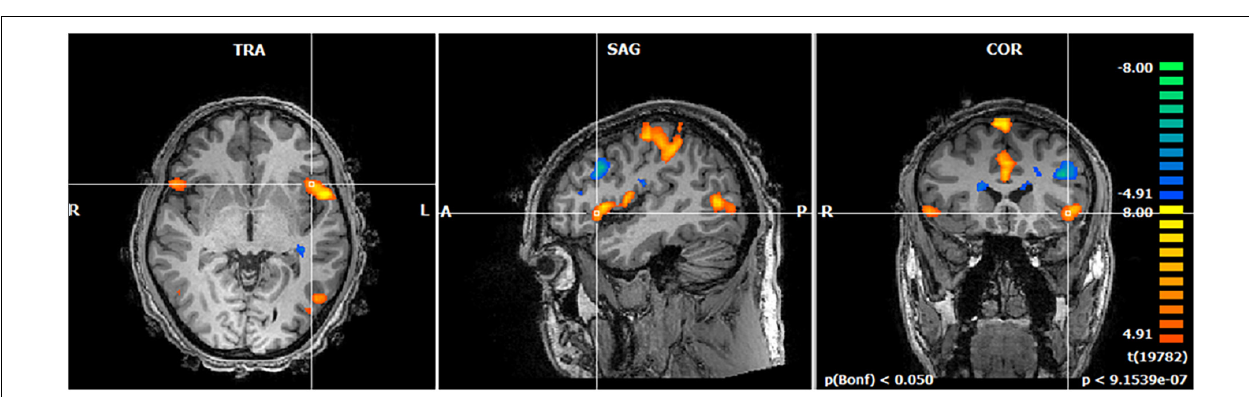
FIGURE 3 | Brain activation map of bug detection when searching for bugs. The regions that are activated at the first insight of bug detection are shown (eureka moment of suspicion) at the group level. We found significant activation in the anterior insula replicating our previous study (Castelhano et al.,